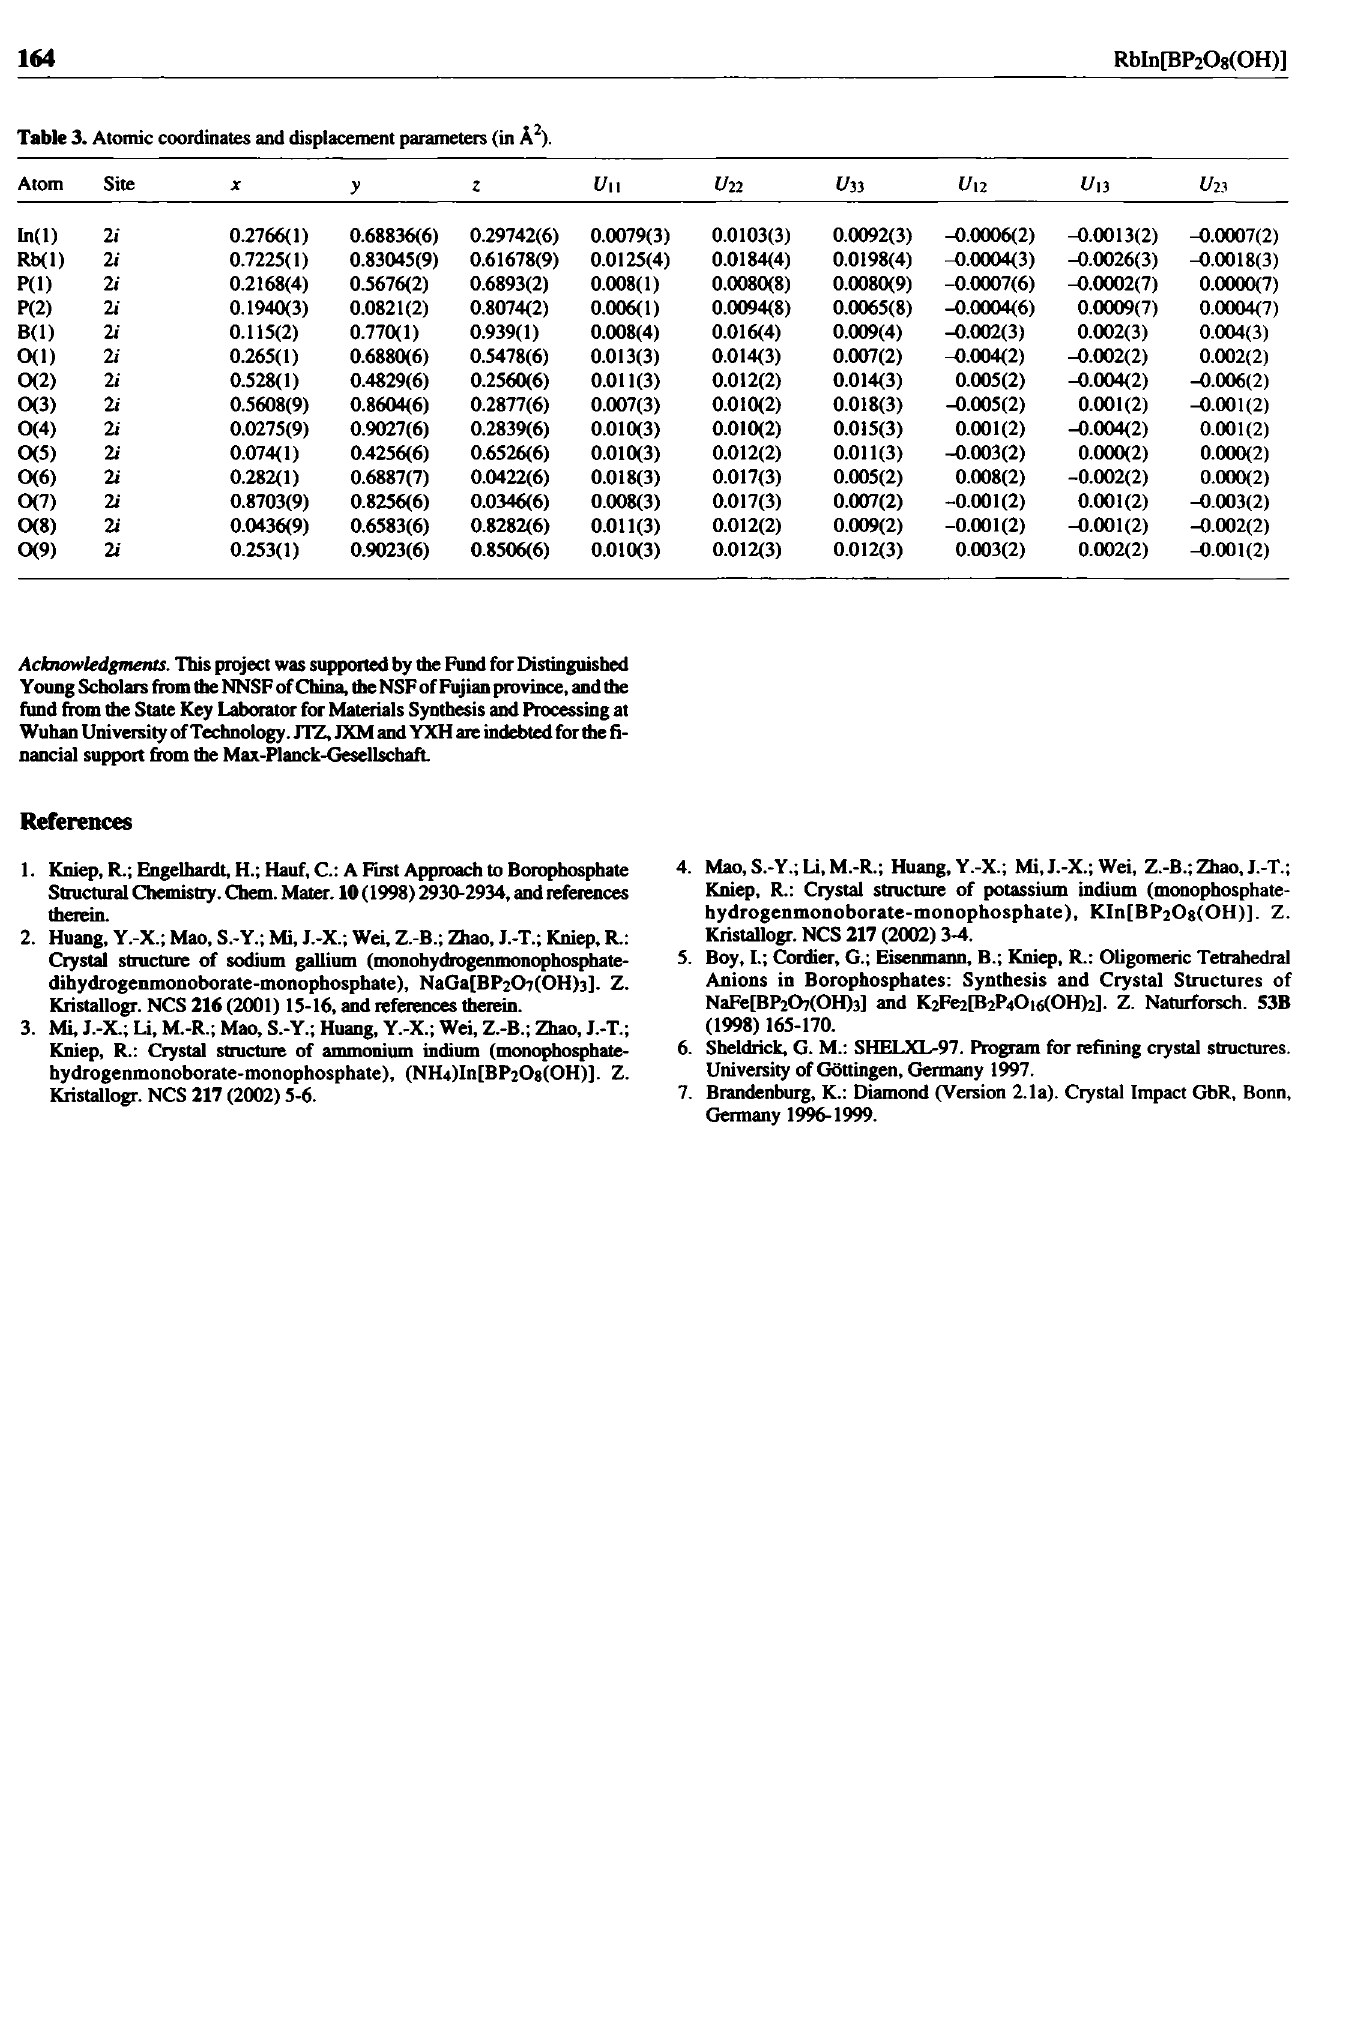
Table 3. Atomic coordinates and displacement parameters (in k 2